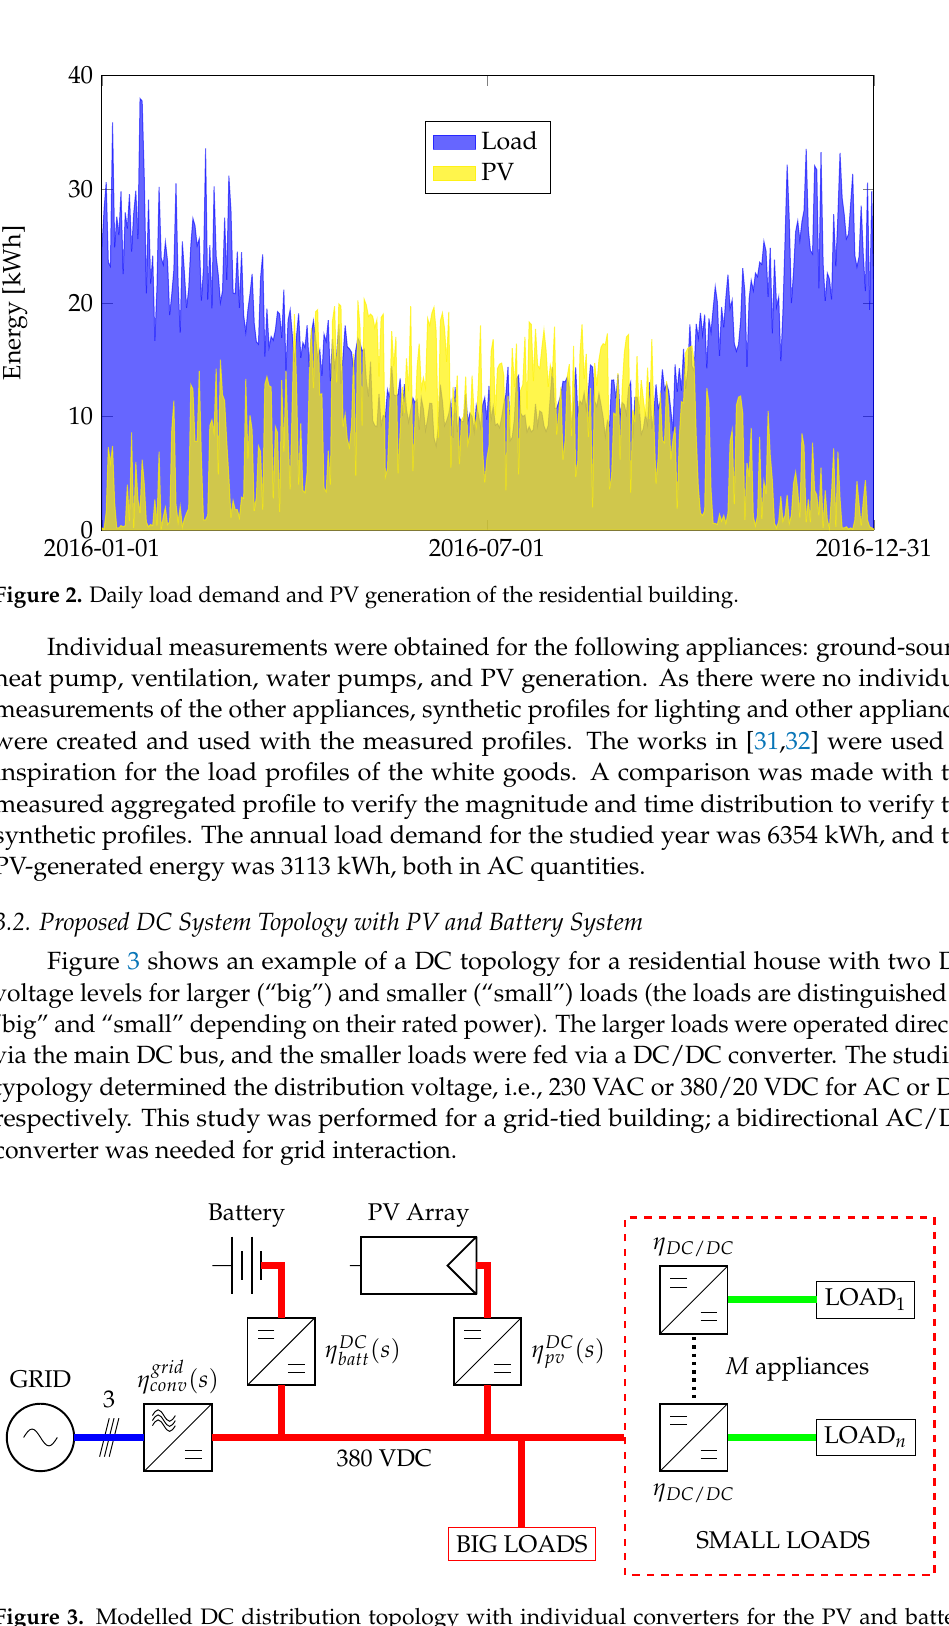
Figure 3. Modelled DC distribution topology with individual converters for the PV and battery system. Loads are distinguished as ”BIG” and ”SMALL” depending on their rated powers, smaller loads are supplied by 20 VDC via a galvanic isolated DC/DC converters.